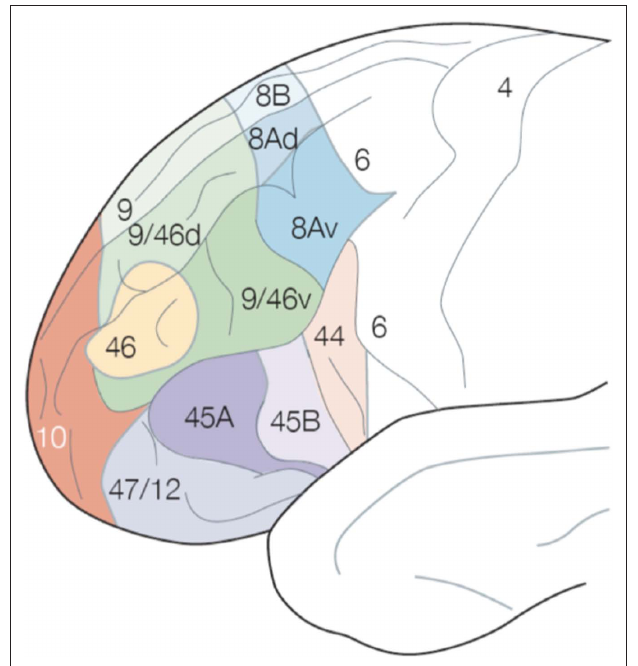
Figure 1 | Brodmann map of the lateral PFC. Reproduced with permission from Ramnani and Owen (2004).